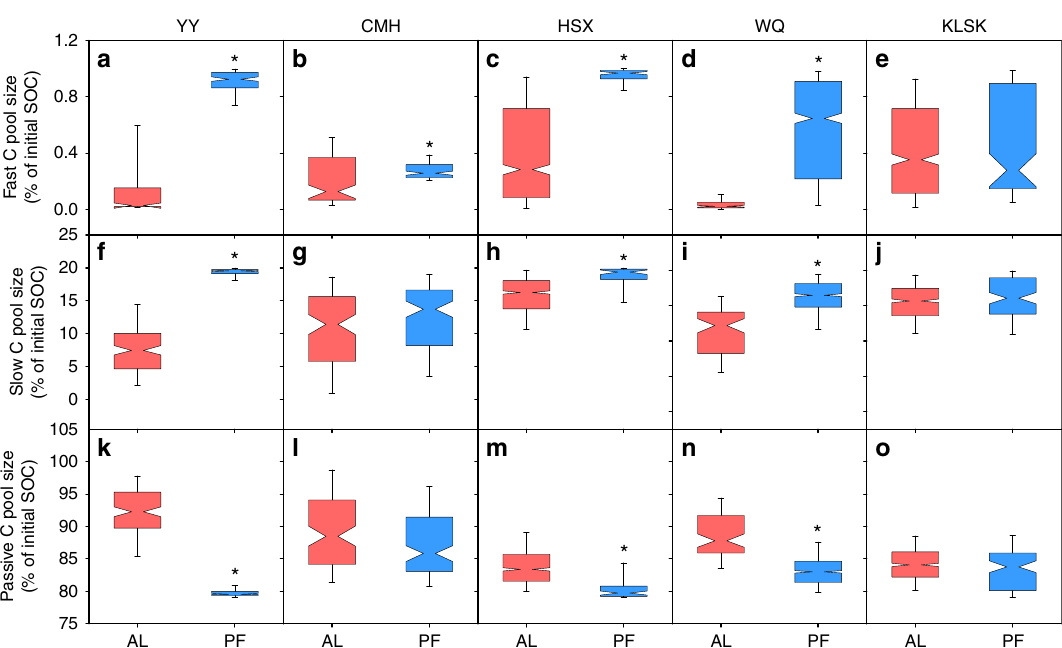
Figure 1 | Comparison of C pools between the active layer and permafrost deposits. The sub-panels correspond to the relative sizes of the fast C pool ( a – e ), the slow C pool ( f – j ) and the passive C pool ( k – o ) of the active layer (AL, red notched box) and permafrost deposits (PF, blue notched box) at five study sites including Youyun (YY) and Changmahe (CMH) in Maqin County, Huashixia (HSX) in Maduo County , Wenquan (WQ) in Xinghai County and Kunlunshankou (KLSK) in Geermu—see Supplementary Fig. 1 for locations. An asterisk indicates significant differences between the two layers. The whiskers illustrate the 5th and 95th percentiles, the ends of the boxes represent the 25th and 75th quartiles (interquartile range), and the notches represent the 95% confidence intervals.